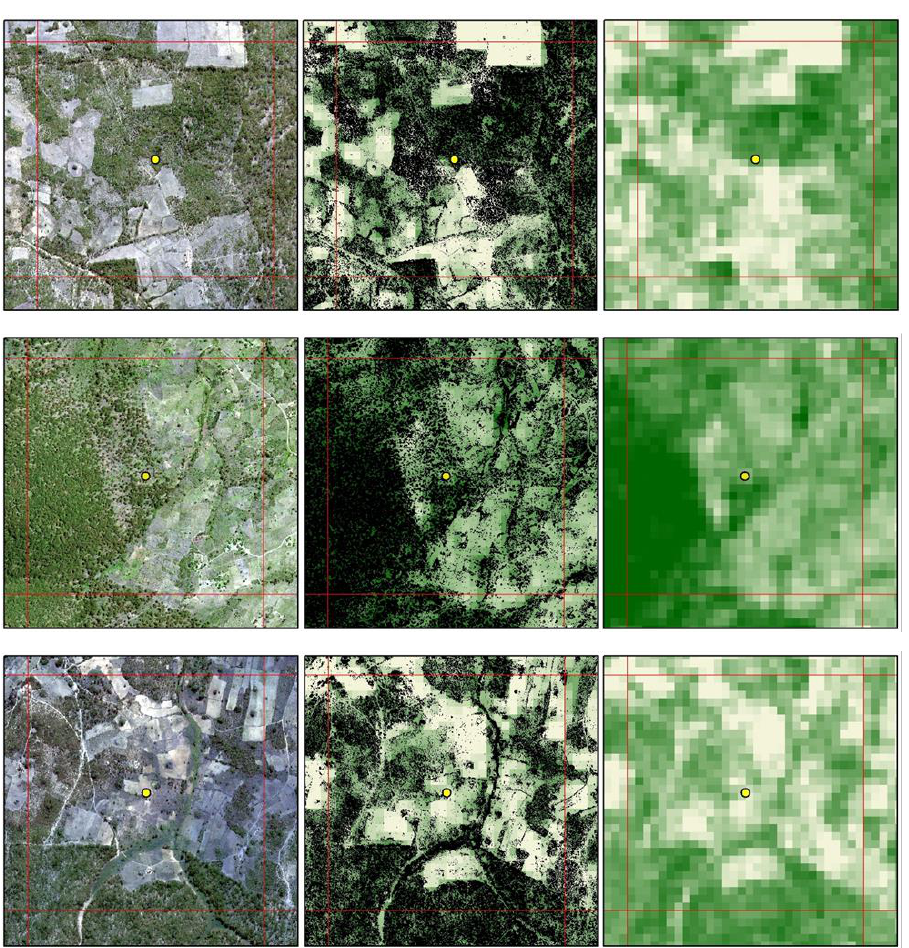
Figure A3. Landscape test sites where digital hyperspatial satellite data are used to produce an f C product and compared to the Landsat f C product. Image on the left is the raw hyperspatial data. Middle image is an tree cover product from hyperspatial data. Image on the right is the Landsat f C product.